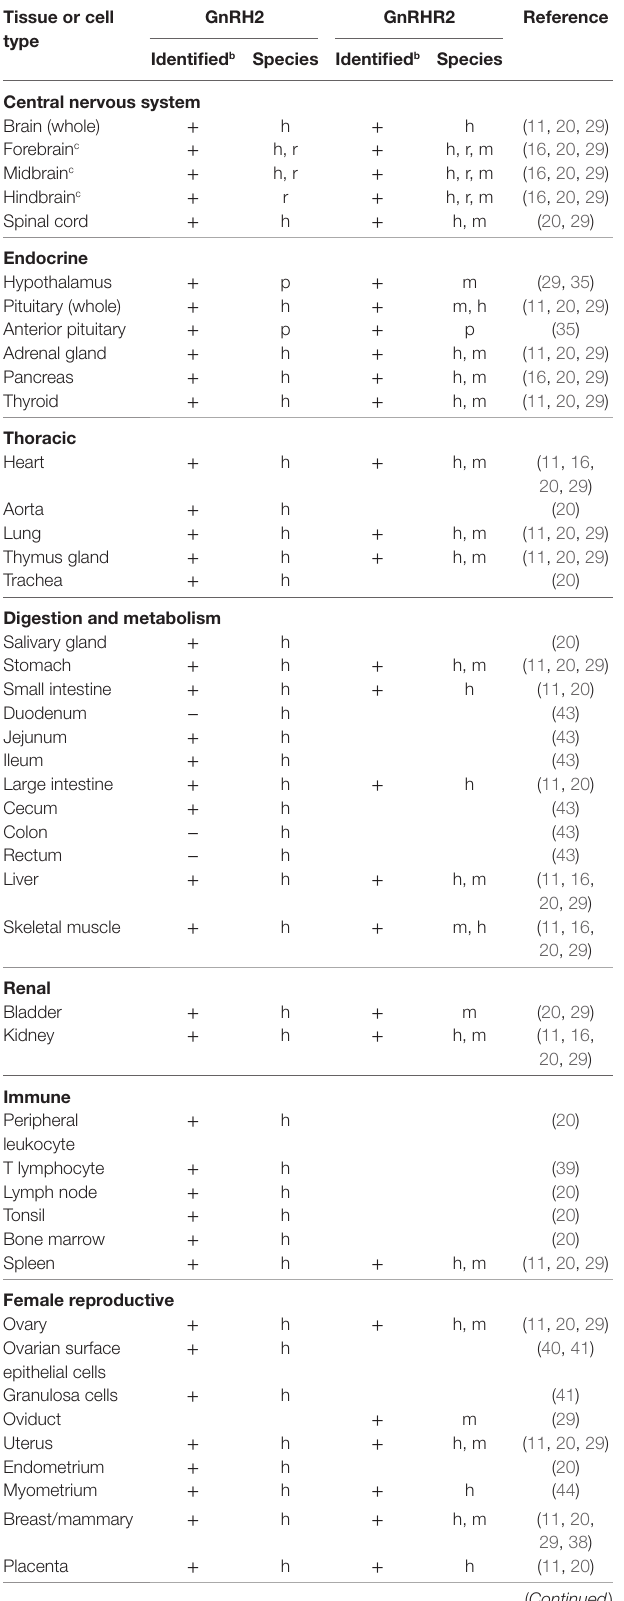
TABLe 3 | Production of GnRH2 and GnRHR2 in mammalian tissues.